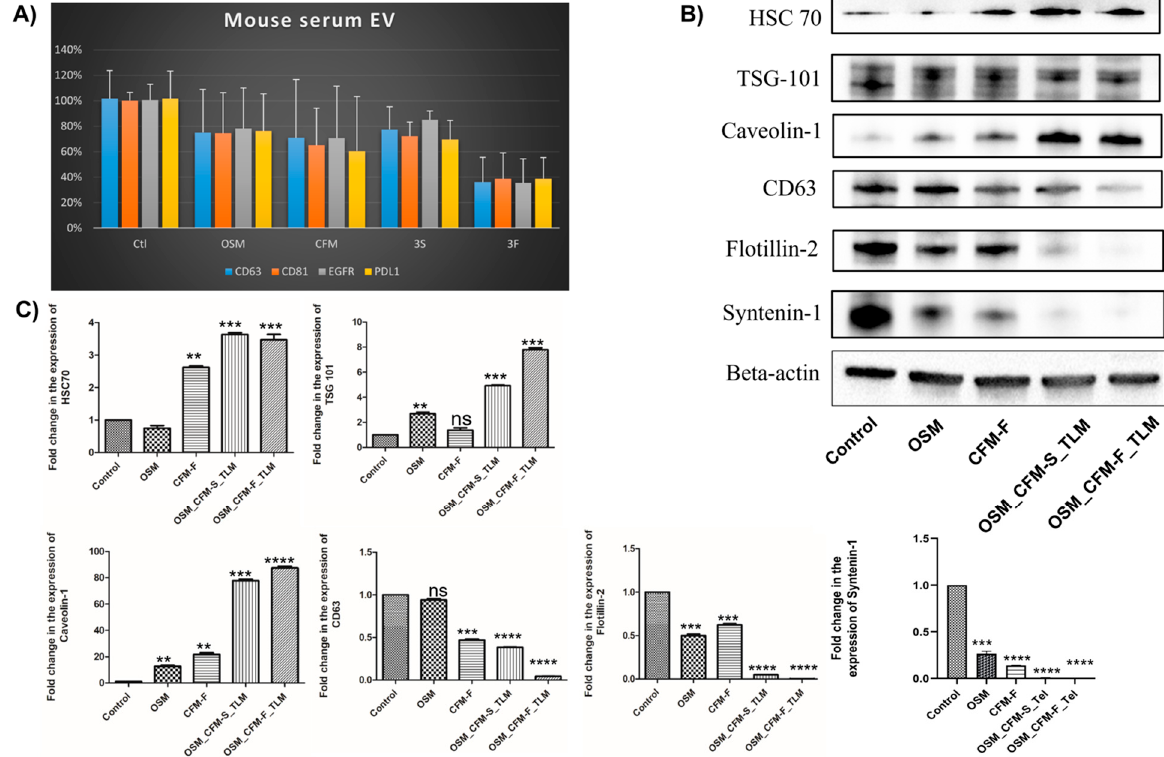
Figure 5. Analysis of exosomal markers in H1975 xenografts and serum samples: ( A ) Bar graph represents the TotalSeq assay in serum samples of H1975 tumor bearing athymic nude mice after treatment with different drugs and their combinations; ( B ) Representative Western blots showing expressions of exosomal protein markers after treatment in H1975 tumor tissue homogenates; ( C ) bar graphs represent the densitometric analysis of respective Western blots. Data represented as three different experiments and presented as mean ± SEM. ns p > 0.05 ** p < 0.01, and *** p < 0.001, was considered significant when compared to control. **** p < 0.0001 was considered significant when compared to